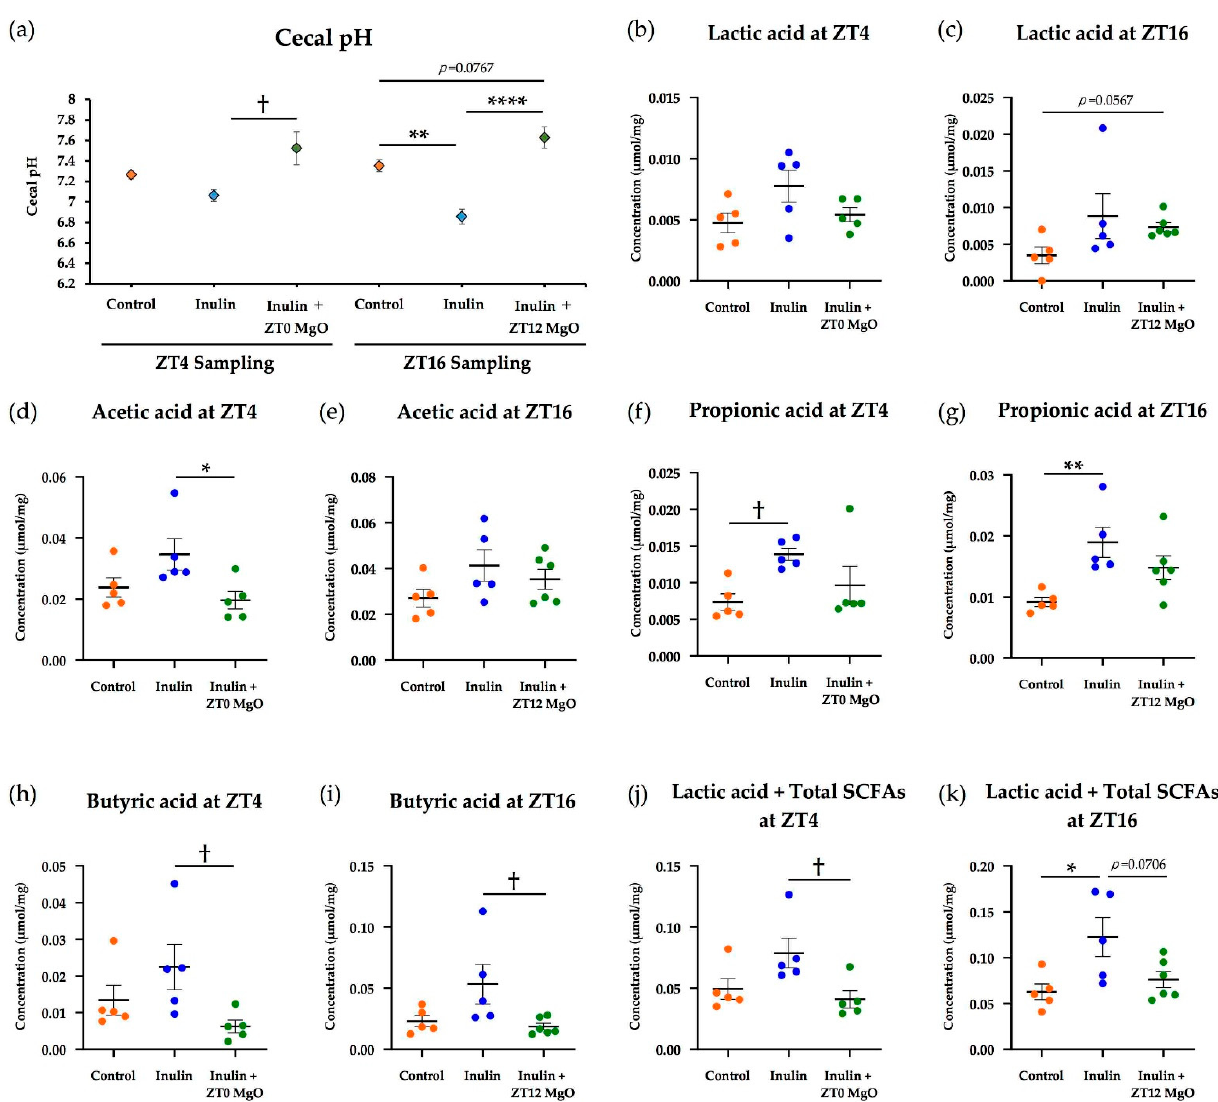
Figure 7. The MgO administration timing effects on cecal pH and cecal SCFAs in mice. ( a ) Cecal pH. ( b ) Lactic acid concentration of the cecal contents at ZT4. ( c ) Lactic acid concentration of the cecal contents at ZT16. ( d ) Acetic acid concentration of the cecal contents at ZT4. ( e ) Acetic acid concentration of the cecal contents at ZT16. ( f ) Propionic acid concentration of the cecal contents at ZT4. ( g ) Propionic acid concentration of the cecal contents at ZT16. ( h ) Butyric acid concentration of the cecal contents at ZT4. ( i ) Butyric acid concentration of the cecal contents at ZT16. ( j ) Lactic acid concentration and total SCFA concentrations of the cecal contents at ZT4. ( k ) Lactic acid concentration and total SCFA concentrations of the cecal contents at ZT16. Total SCFA concentration is the total of acetic acid concentration, propionic acid concentration, and butyric acid concentration. Inulin was mixed with the HFD at a ratio of 2.5% in the inulin group and the MgO combination group. Magnesium oxide at 250 mg/kg was orally administered to the inulin + MgO group. The MgO administration time was ZT0 or ZT12. Concentrations of lactic acid and each SCFA were calculated per dry weight of the cecal contents. All data are expressed as mean ± standard error (Each group n = 5–6). * p < 0.05, ** p < 0.01, and **** p < 0.0001, evaluated using the one-way ANOVA with Tukey’s post hoc test. † p < 0.05, evaluated using the Kruskal-Wallis test with Dunn’s post hoc test. MgO: magnesium oxide. SCFA: short-chain fatty